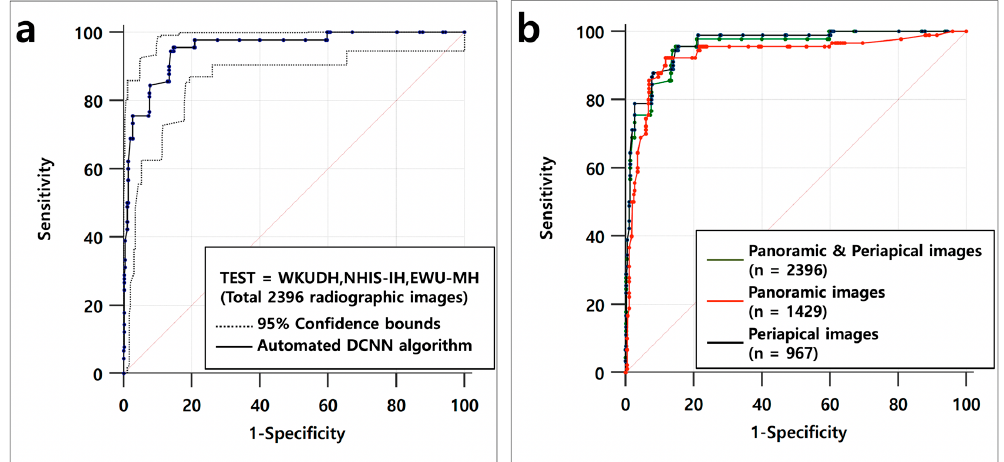
Figure 2. ( a ) Receiver operating characteristic (ROC) curve for classification of six types of DISs in the testing dataset, which consisted of 2396 panoramic and periapical radiographic images. ( b ) The accuracy of the automated DCNN for the test dataset did not show a significant difference among the three ROC curves based on DeLong’s method. Table 2. Pairwise comparison of ROC curve for classification of six different types of DISs in the testing dataset.